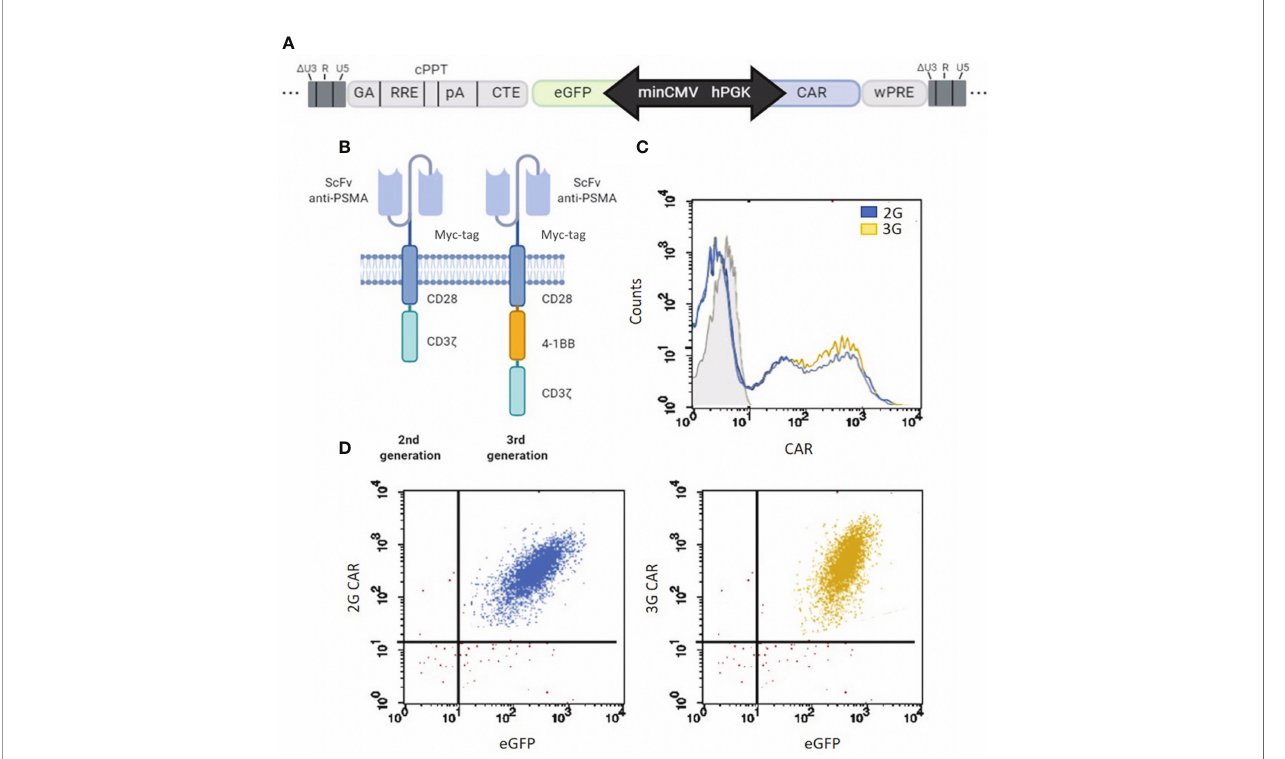
FIGURE 1 | CAR structure development and expression. (A) Map of the minCMVPGK bidirectional promoter. CAR gene expression is regulated by the hPGK promoter, while the reporter gene (eGFP) is under the control of the minCMV promoter. (B) Schematic representation of the two different anti-PSMA CAR designs. 2G and 3G are second- and third-generation CARs, respectively, whose antigen-binding domain comes from antibody IgGD2B (26), and contain a myc tag for cyto fl uorimetric detection. The two CARs are different for the intracellular costimulatory domains, which are composed of a CD28 plus CD3 z moieties in 2G or CD28, 4-1BB (CD137) and CD3 z elements in 3G. (C) 2G and 3G CAR transduction. Flow cytometry of CAR expression (2G in light blue and 3G in yellow) in T cells at 4 weeks post LV transduction. Grey histogram represents the isotype control. (D) Co-expression of CAR and eGFP in 2G and 3G populations of LV-transduced T cells. More than 90% of cells co-expressed both CAR (c-myc) and the reporter gene (eGFP). The events of the dot plot were gated on total viable